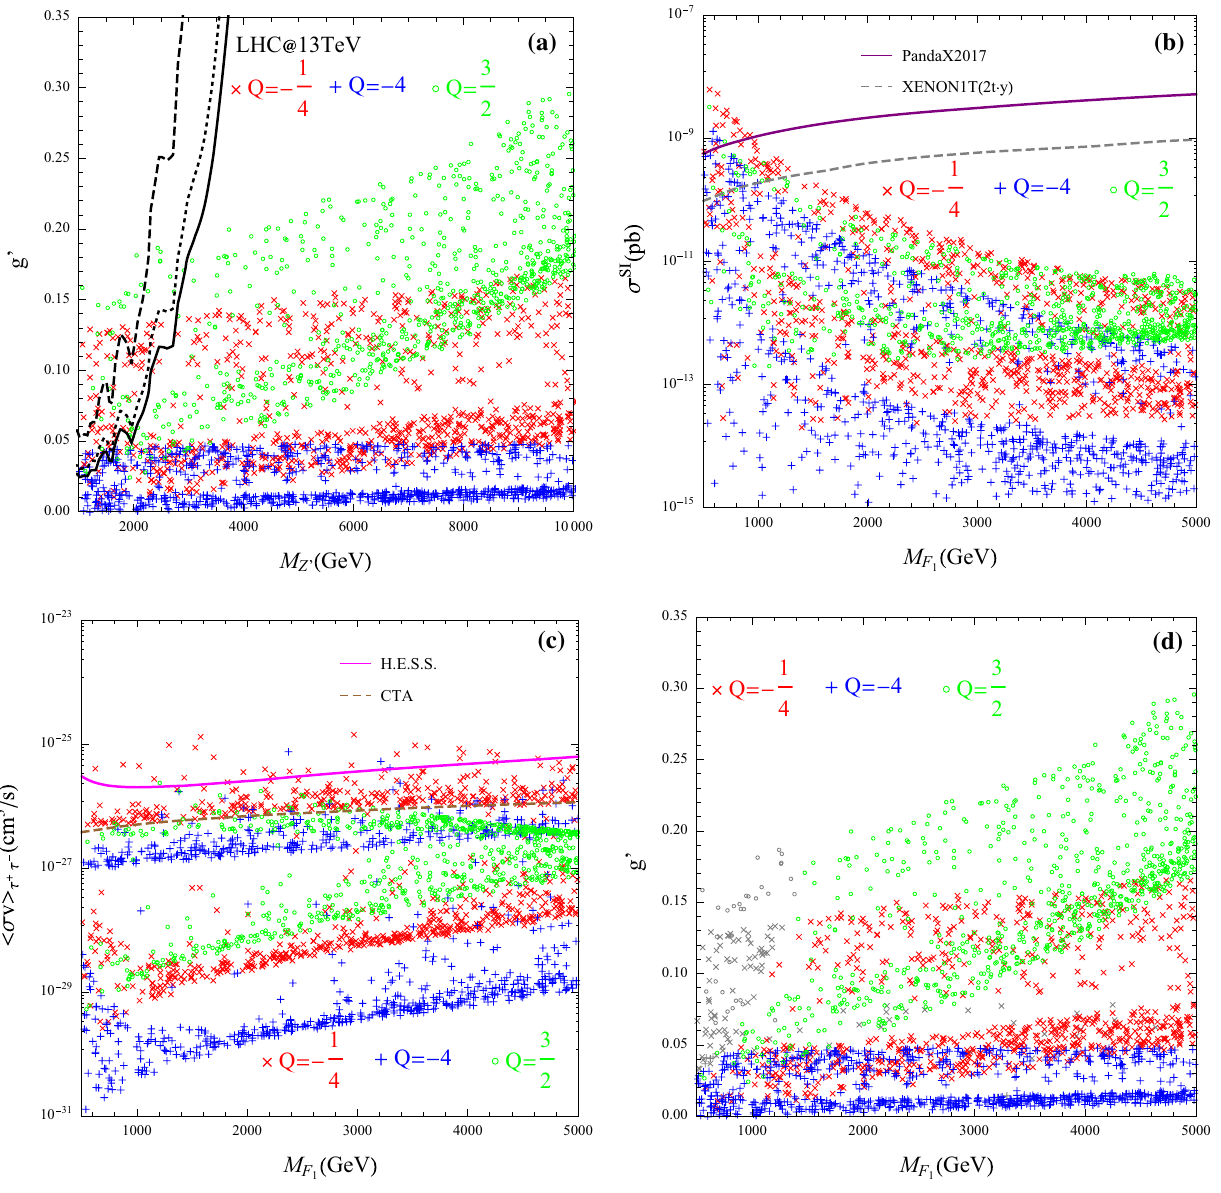
Fig. 15 Same as Fig. 14, but for fermion DM F 1 dicted spin-independent DM-nucleon scattering cross sec- vived simples after imposing all constraints are depicted in . Clearly, the case of Q = 3 , no survived points are obtained, due tion as a function of M Fig. 14d. For Q = 3 H 0 1 2 2 , one needs to tight direct detection constraints. For Q = − 1 is fully excluded by PandaX2017. Although for Q = − 1 , 4 4 (cid:3) 1 . 2 TeV to escape all constraints, while for Q = − 4, M most samples could survive under PandaX2017, most sam- H 0 1 ples are within the reach of XENON1T(2t · y). And if no sig- sub-TeV H 0 with small g (cid:2) ∼ 0 . 01 is still viable. 1 should fall in nature is observed by XENON1T(2t · y), M The scanning results for fermion DM F 1 are shown in H 0 1 the range [ 1200 , 4400 ] GeV. As for Q = − 4, most sam- Fig. 15. Viable parameter space for relic density in the g (cid:2) - ples could escape direct detection limits even in the future. M Z (cid:2) plane are shown in Fig. 15a. Comparing with scalar DM, a smaller g (cid:2) is usually needed for same value of M DM and Q . Hence, it is more easier for fermion DM to satisfy the constraints from LHC@13TeV. Especially for Q = −